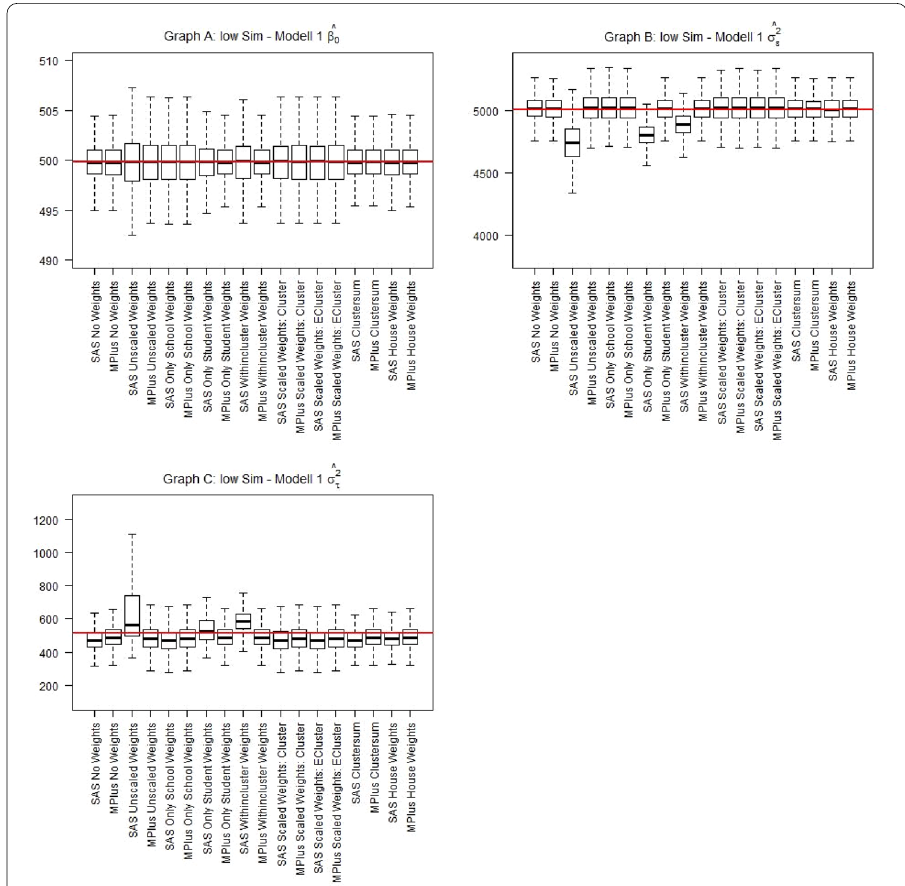
Fig. 2 Simulation outcomes for data reflecting low variances between schools. Model 1 is declared as y ij = β 0 + τ i + ε ij , Model 2 as y ij = β 0 + β 1 ∗ x ij + τ i + ε ij and Model 3 as